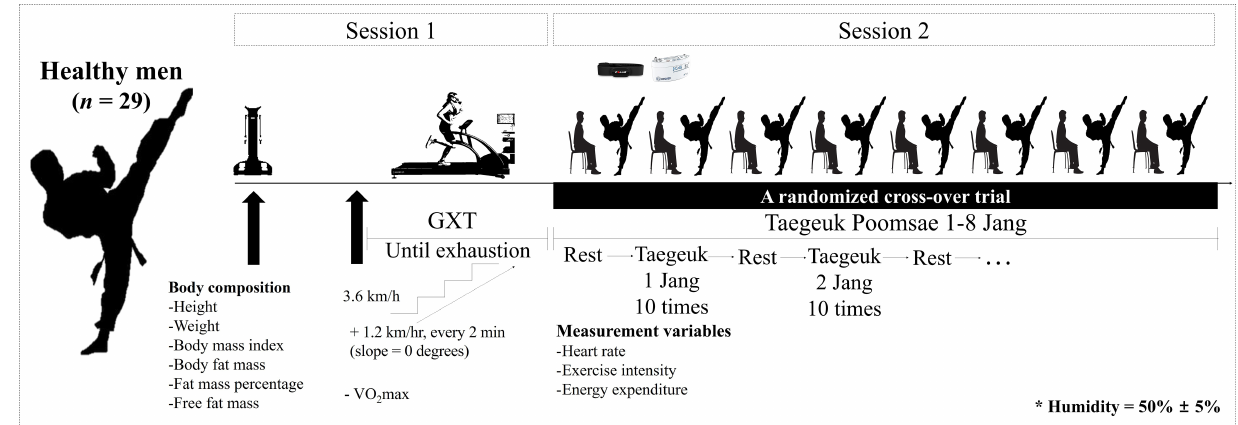
Fig. 1. Study design. VO 2 max, maximal oxygen uptake.